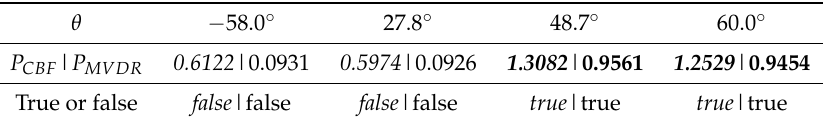
Figure 5. Resolution probability versus ∆ θ , with θ 1 = 20 ◦ , θ 2 = θ 1 + ∆ θ . Table 3. Ambiguity check results of classical beamforming (CBF) and minimum variance distortionless response (MVDR) with T = 200 and SNR = 5